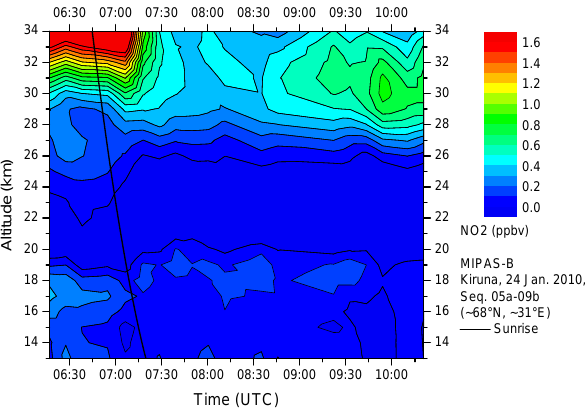
Fig. 11. Temporal evolution of NO 2 amounts as calculated by EMAC. ones but simulated temporal and vertical gradients are